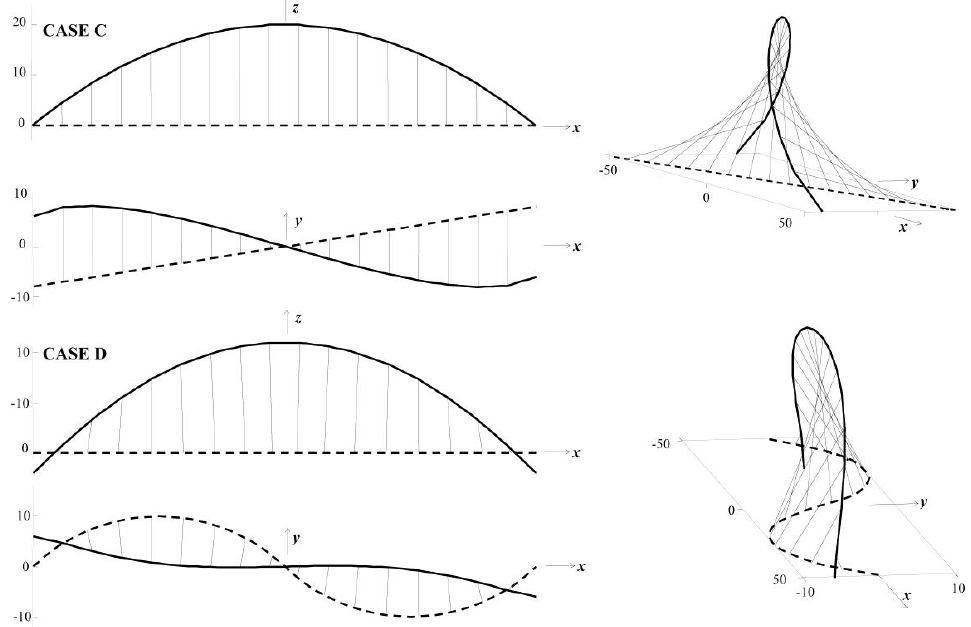
Figure 13. Case studies C and D. Anti-funicular geometry (m): Elevation, plan, and perspective views.